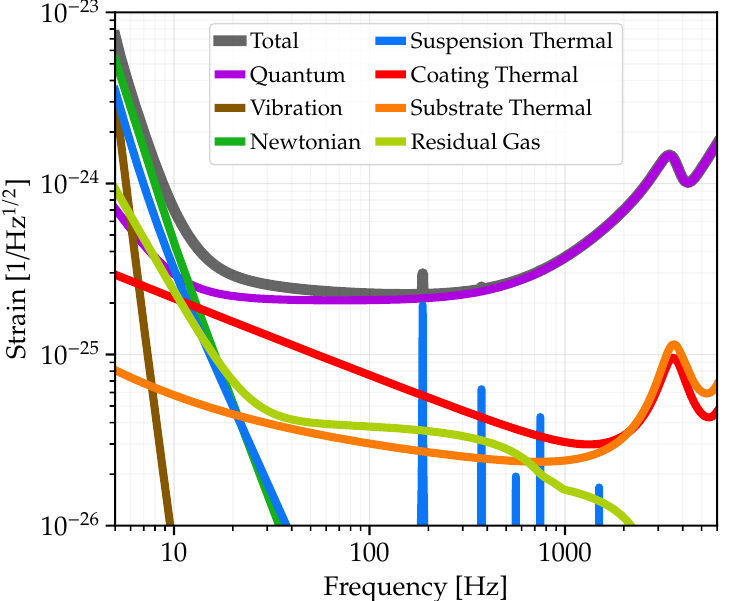
Figure 5. Fundamental noise contributions to the overall strain sensitivity of a 40km Cosmic Explorer detector, discussed in Section 3.2. The fundamental noises are modeled in pygwinc [92], and the noise here is referred to a source arriving from 15° off the detector’s